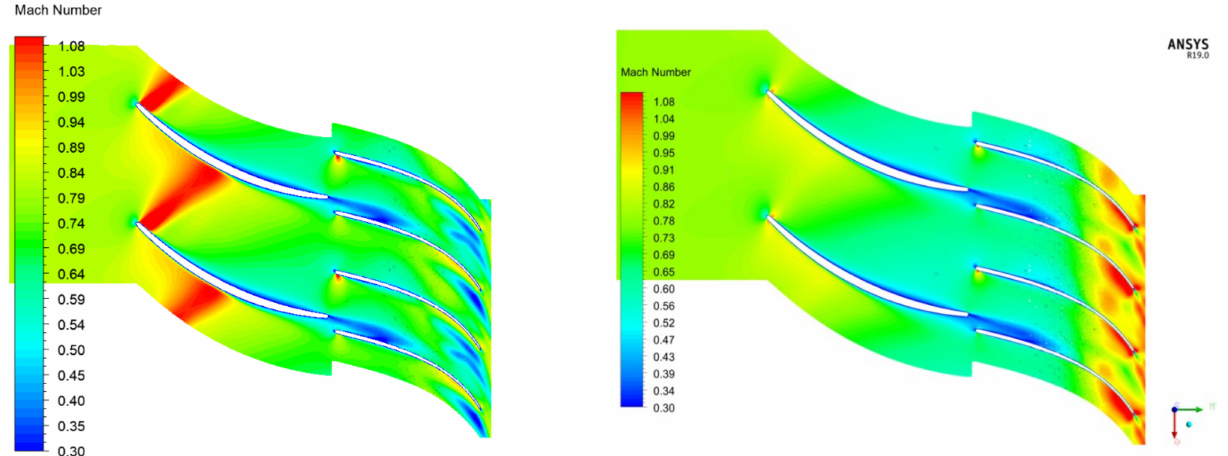
Figure 27. Mach number contour at choking condition, Impeller with blade channel modification ( left ) and without ( right